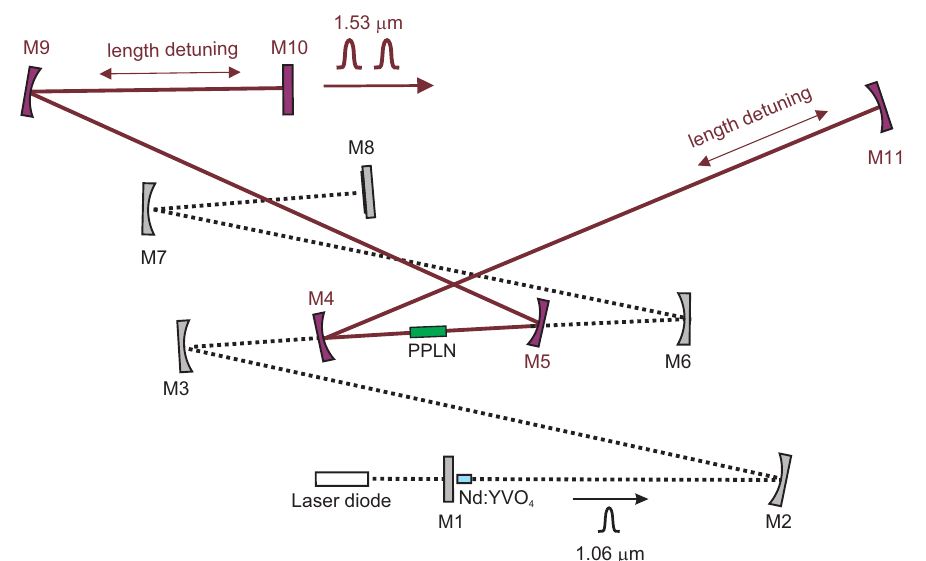
Figure 1. Sketch of the diode-pumped mode-locked Nd:YVO 4 laser with a linear intracavity OPO.